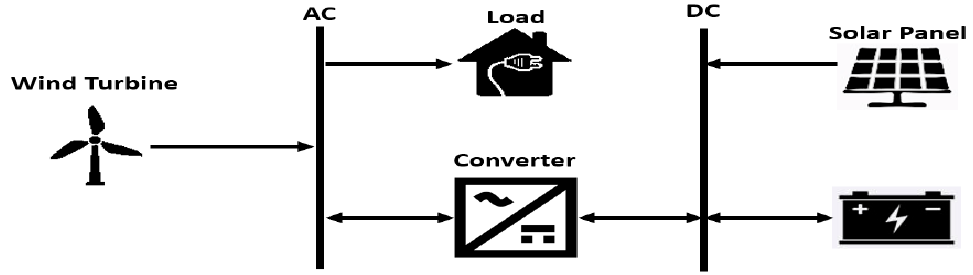
Figure 1. Schematic diagram of the off-grid hybrid renewable energy system .